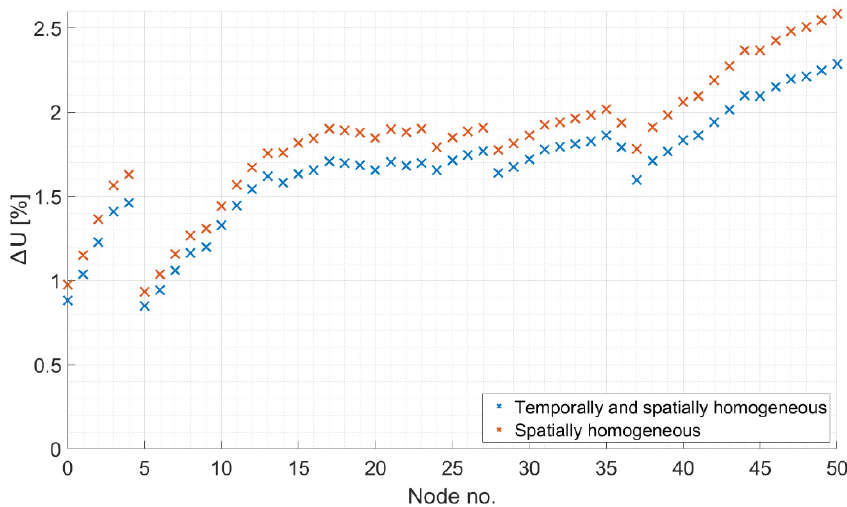
Figure 4. Average relative error of voltages for Area 18,680 with Method 1 and 1m.